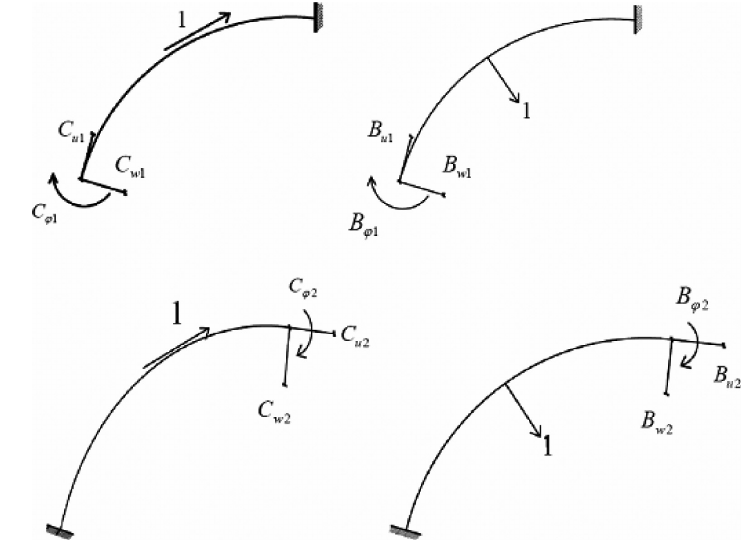
Fig. 3. Illustrations of Basic Displacement